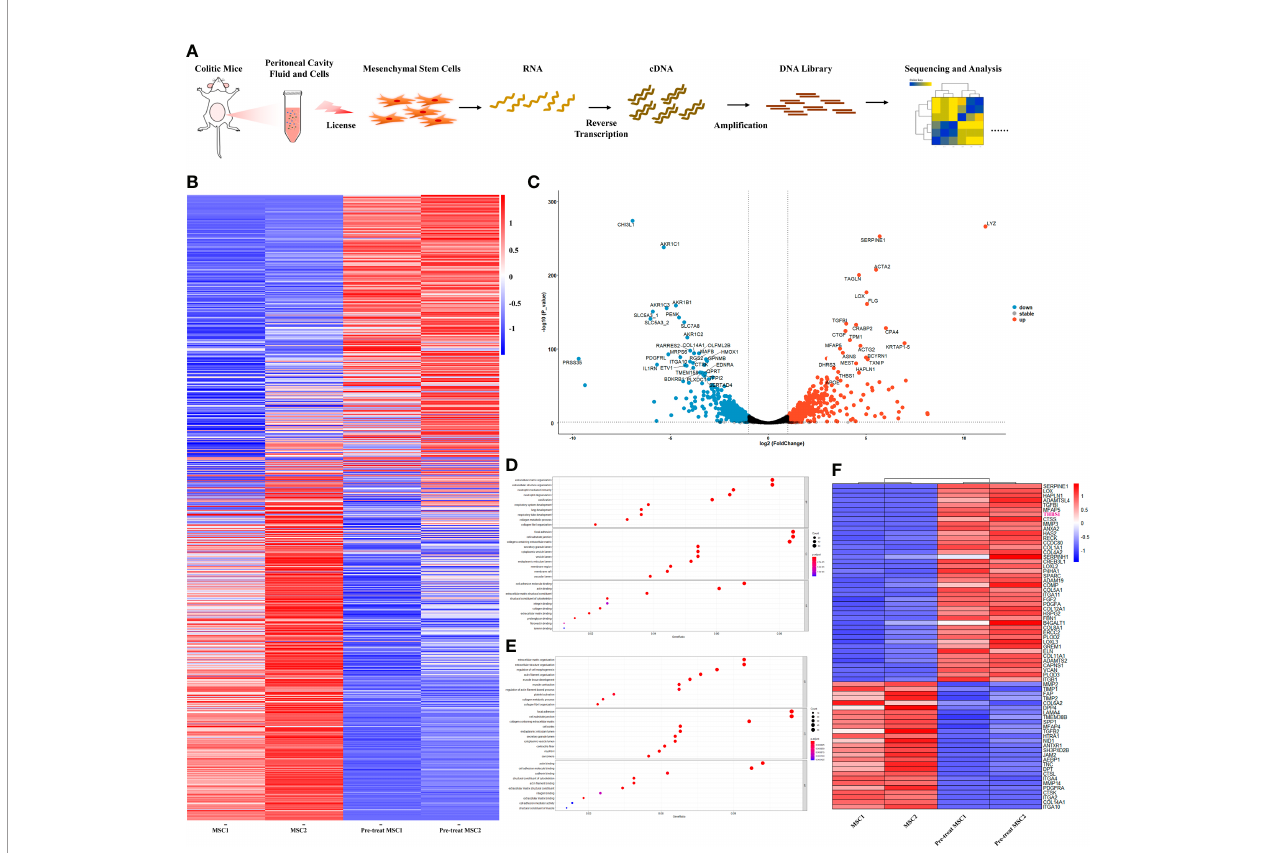
FIGURE 4 | Peritoneal lavage fl uid-primed MSCs enhanced the expression of expression. Peritoneal lavage fl uid (including peritoneal cells) was collected from colitis mice and then cocultured with MSCs; simultaneously, MSCs cultured alone were used as a control. Next, the gene expression pro fi le of MSCs was obtained by bulk RNA sequencing for further analysis. (A) Overview of the work fl ow. (B) Heatmap visualization for total included genes in pretreated MSCs compared to control MSCs. (C) Volcano plots for the distribution of differentially expressed genes (DEGs) from the comparison between primed MSCs and control MSCs. (D) GO enrichment analysis of all DEGs from the comparison between primed MSCs and control MSCs. (E) GO enrichment analysis of the upregulated DEGs from the comparison between primed MSCs and control MSCs. (F) Heatmap visualization for DEGs clustered in the extracellular matrix organization